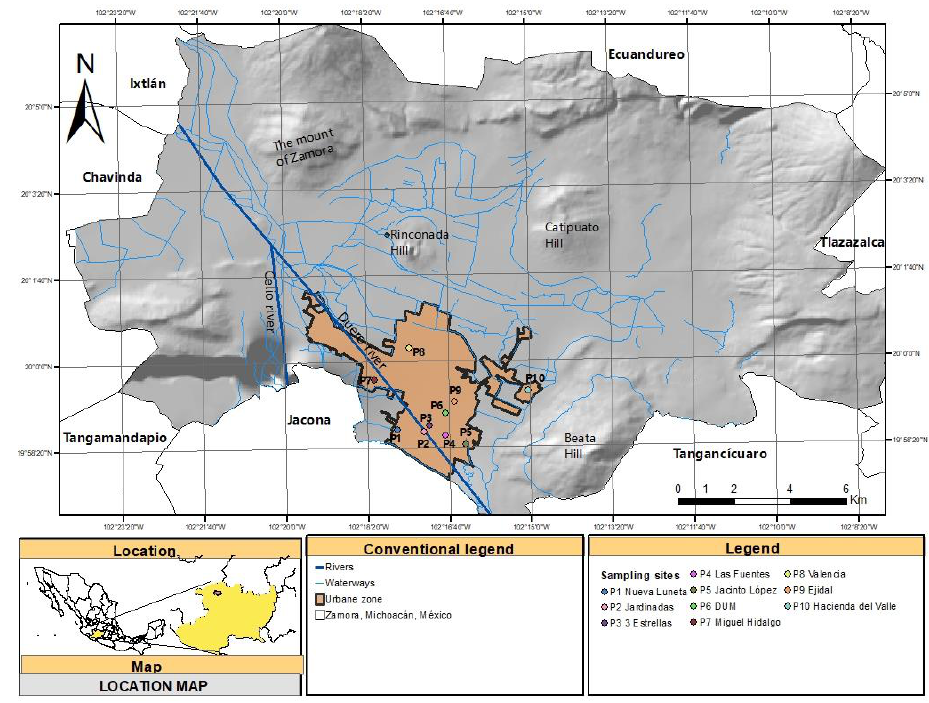
Figure 1. Location of the sampling sites in the urban area of Zamora, Mexico.